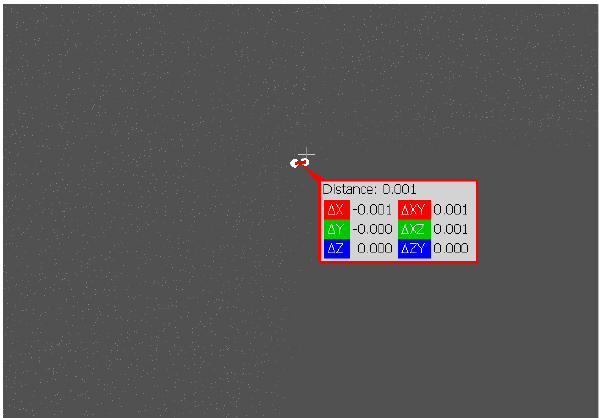
Figure 3. TLS point cloud density.